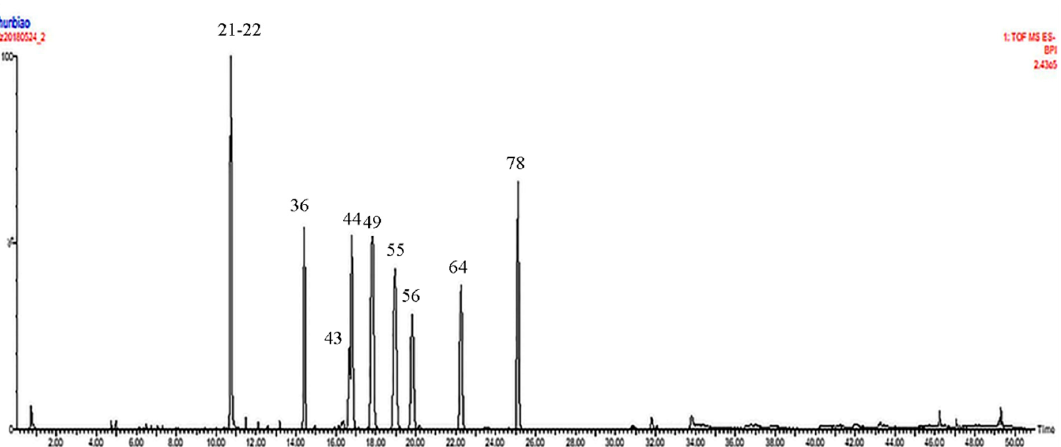
Figure 2. The negative ion BPI chromatogram from a mixed solution of reference standards of ginsenosides based on UPLC-QTOF-MS E .